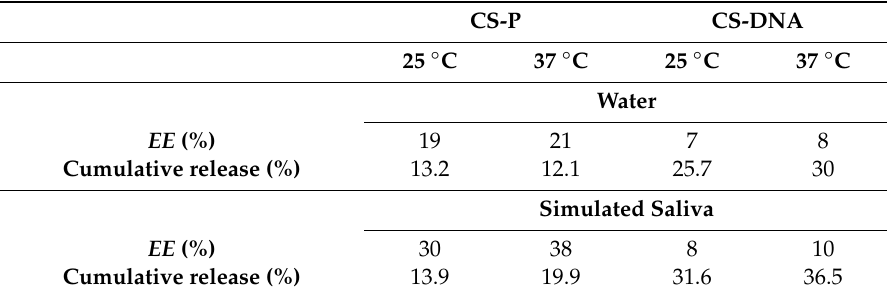
Table 1. Encapsulation e ffi ciency and cumulative release of GP in CS-P and CS-DNA coacervate gels, at 25 ◦